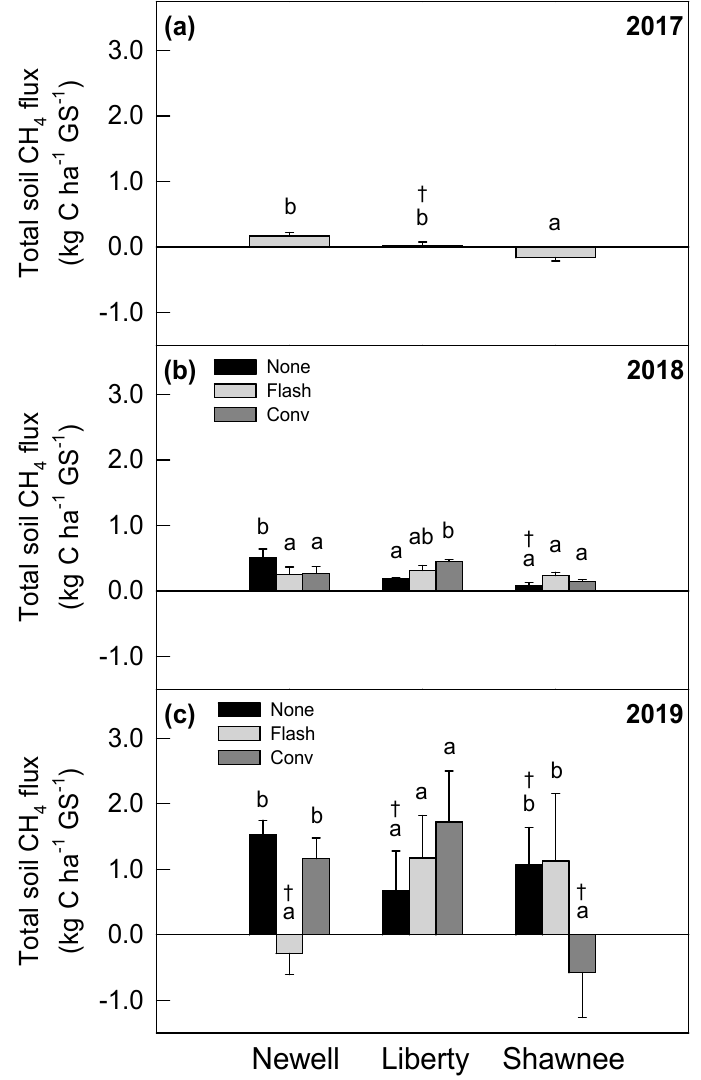
Figure 1. Mean total soil CH 4 fluxes for 2017 ( a ), 2018 ( b ), and 2019 ( c ) growing seasons (GS; 1 April–31 October) for Newell smooth bromegrass, Liberty switchgrass, and Shawnee switchgrass. Different lower-case letters within each grass type indicate grazing treatment differences ( p ≤ 0.05). None = non-grazed, Flash = flash grazed, Conv = conventionally grazed. Symbols (†) indicate soil CH 4 fluxes not significantly different from zero.